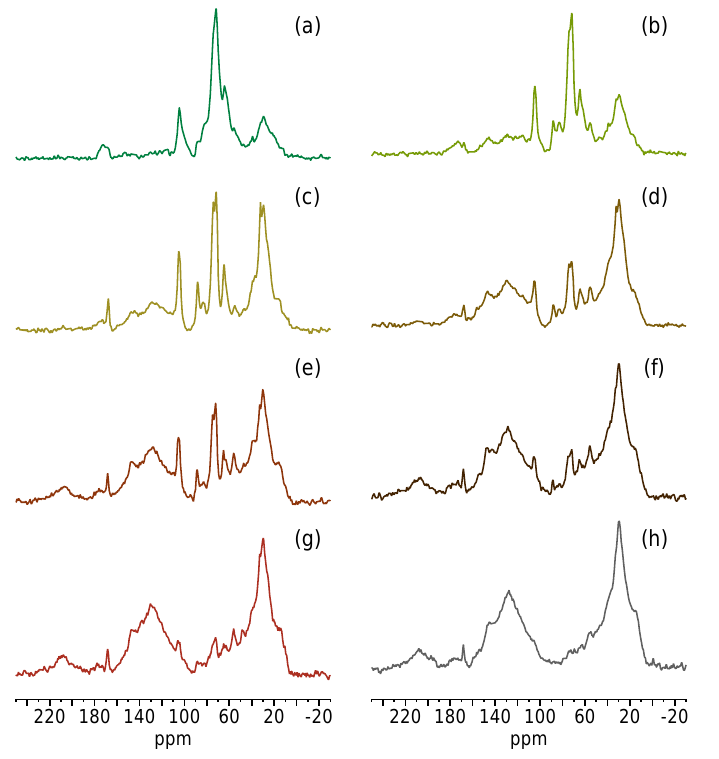
Figure 2. 13 C CP-MAS NMR spectra of FS ( a ) and hydrochar samples HTC_25_180_30 ( b ), HTC_7_250_30 ( c ), HTC_25_250_30 ( d ), HTC_7_250_60 ( e ), HTC_25_250_60 ( f ), HTC_7_250_180 ( g